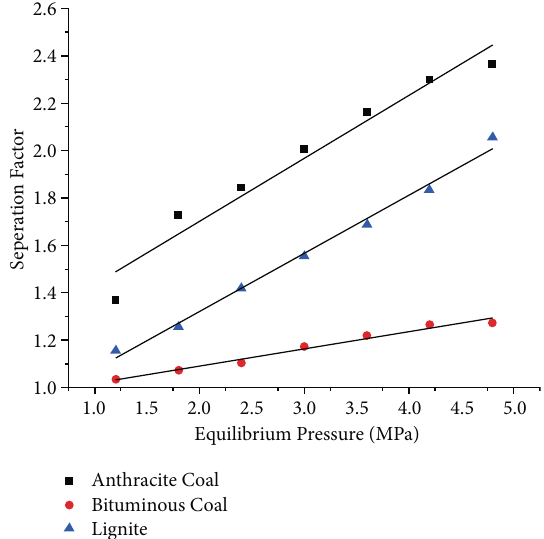
/CH adsorption ratio of 2 4 Figure 8: Displacement coe ffi cient of di ff erent rank coal samples.